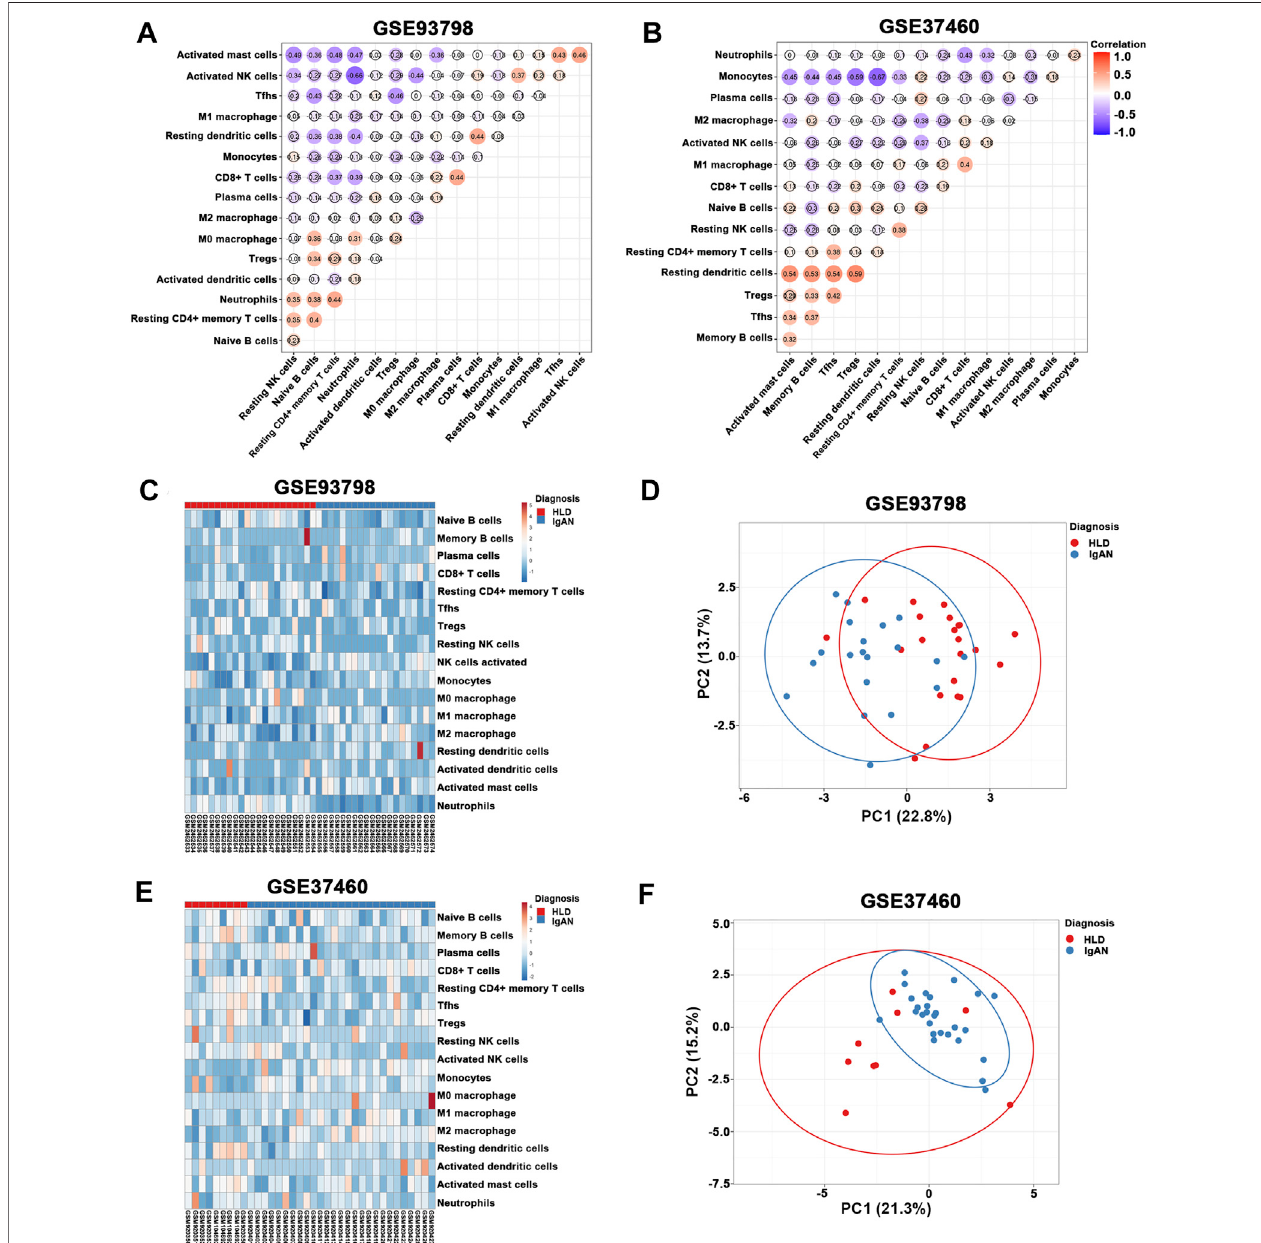
FIGURE 5 | (A,B) Correlation heat map of 22 types of immune cells in GSE93798 and GSE37460. Dot size shows the extent of their relationships, and dot color indicates if they are positively related (red dots) or negatively related (blue dots). The number inside dots indicates the corresponding correlation value between two immune cells. The darker the color, the stronger the correlation. Colored dot without a black line around it denotes signi fi cance ( p < 0.05). (C,D) Heat map and principal component analysis (PCA) cluster plot of immune cells in GSE93798. (E,F) Heat map and PCA cluster plot of immune cells in GSE37460.